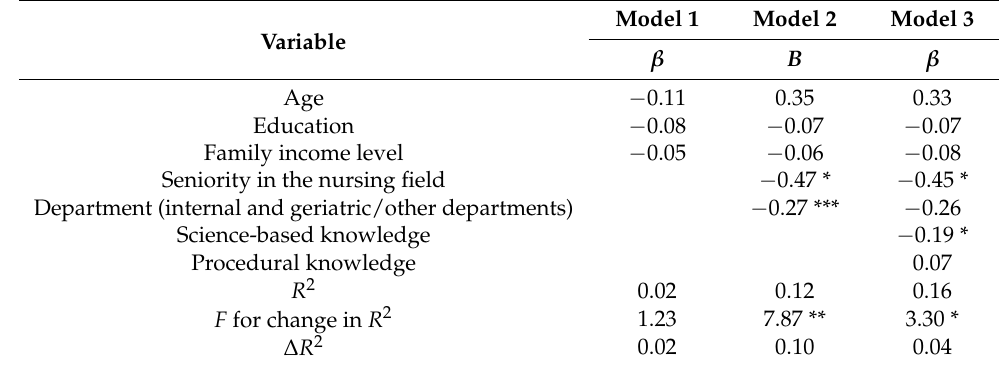
Table 4. Findings from a hierarchical regression analysis for variables accounted for nurses’ COVID- 19-induced anxiety levels ( n =